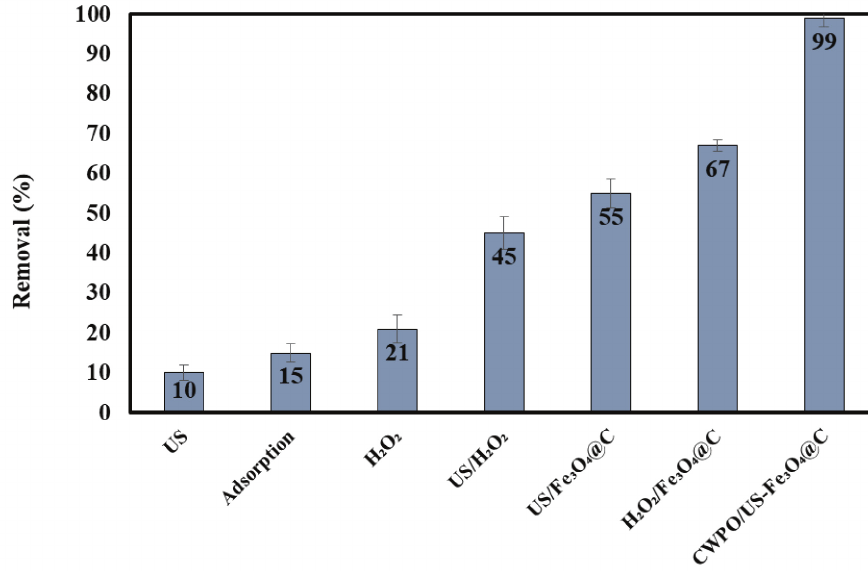
Fig. 9 – Role of other alternatives in 4-CP removal (solution pH 5, initial 4-CP concentration 100 mg L –1 , catalyst dosage 0.8 g L –1 ,